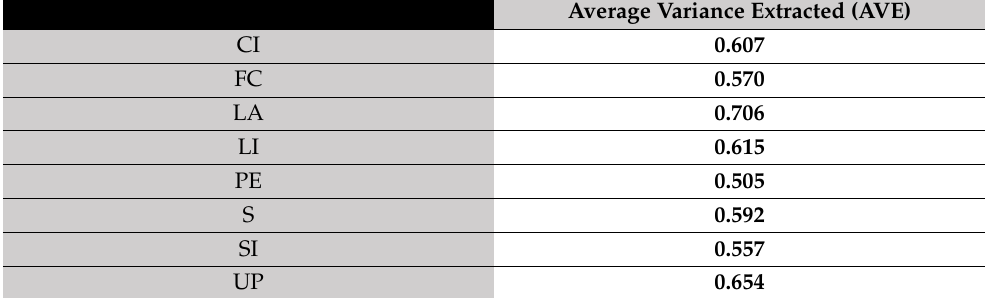
Table 8. Average Variance